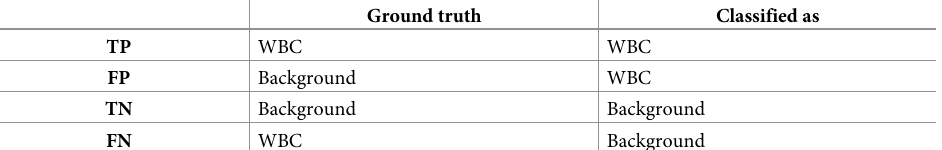
Table 1. Definition of pixels classified as true positives (TP), false positives (FP), true negatives (TN), and false negatives (FN).